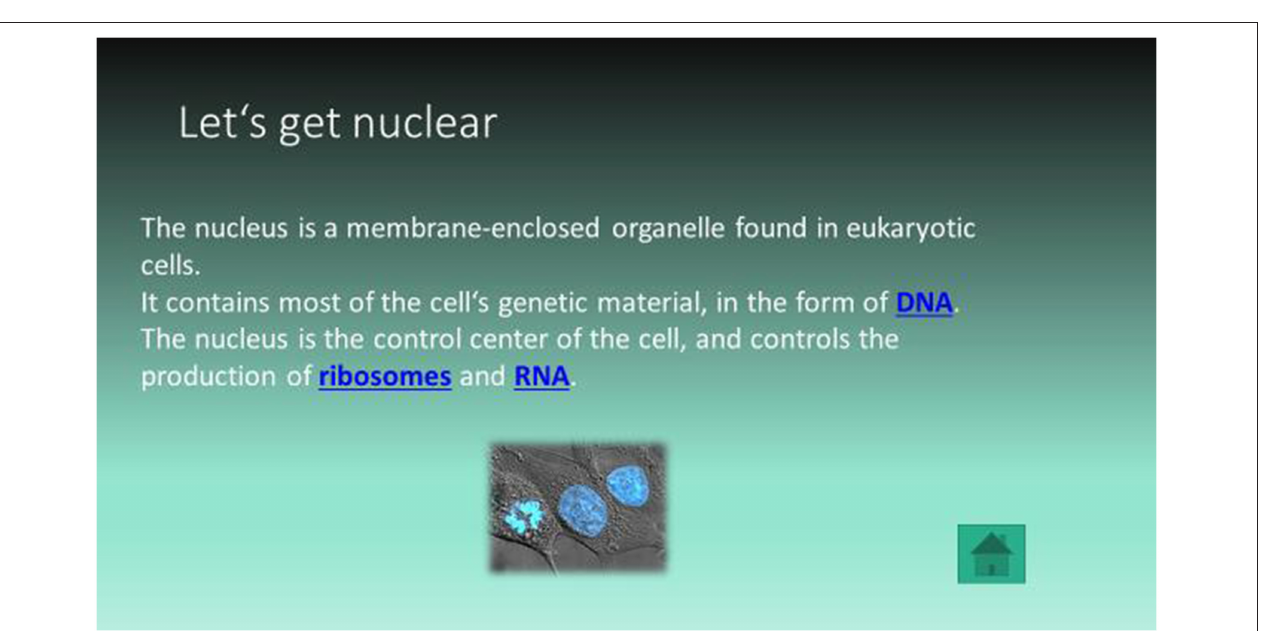
difference in motivational levels between groups was